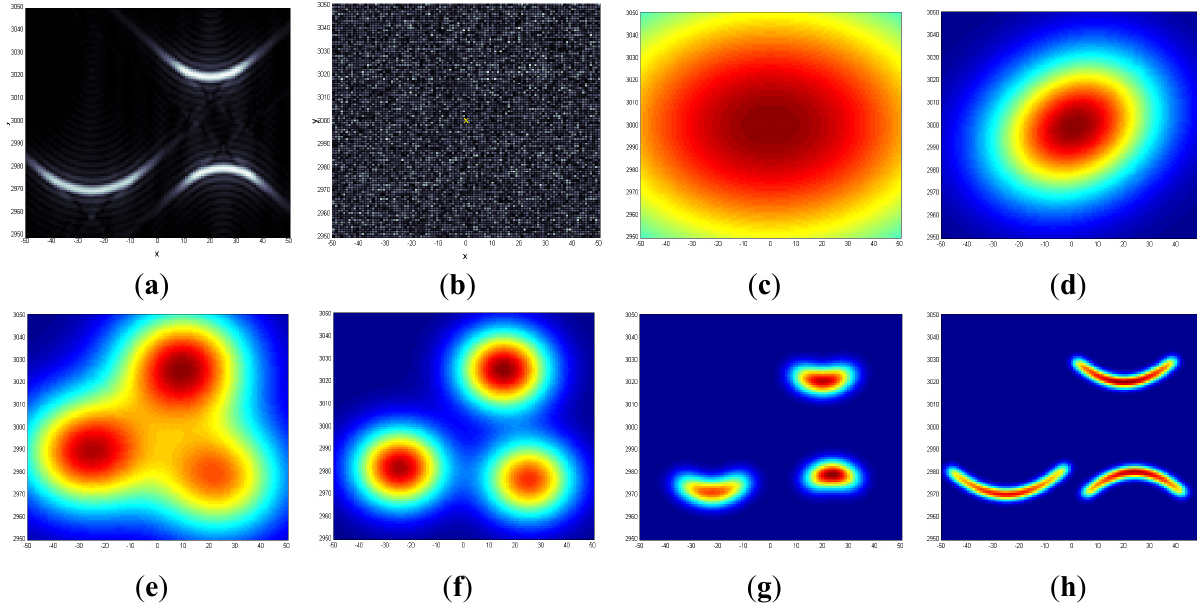
Figure 1. Finding “smile” and “frown” patterns in noise, an example of dynamic logic operation: ( a ) true “smile” and “frown” patterns are shown without noise; ( b ) actual image available for recognition (signals are below noise, signal-to-noise ratio is between ½ and ¼, 100 times lower than usually considered necessary); ( c ) an initial fuzzy blob-model, the vagueness corresponds to uncertainty of knowledge; ( d ) through ( h ) show improved models at various steps of dynamic logic (DL) (equation A3 are solved in 22 steps). Between stages ( d ) and ( e ) the algorithm tried to fit the data with more than one model and decided that it needs three blob-models to “understand” the content of the data. There are several types of models: One uniform model describing noise (it is not shown) and a variable number of blob-models and parabolic models, which number, location, and curvature are estimated from the data. Until about stage ( g ) the algorithm “thought” in terms of simple blob models, at ( g ) and beyond, the algorithm decided that it needs more complex parabolic models to describe the data. Iterations stopped at ( h ), when similarity (equation A1) stopped